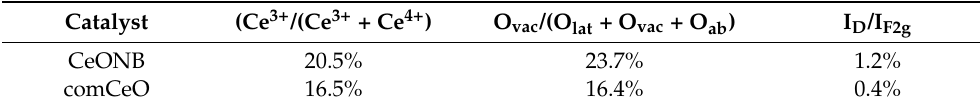
Table 1. Property analyses of CeONB and comCeO.